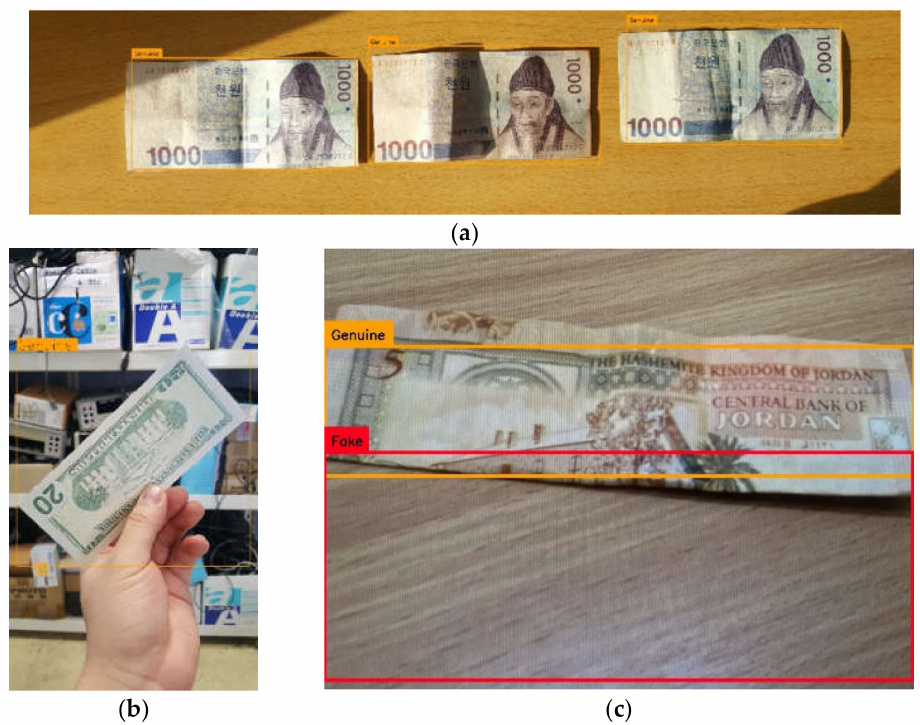
Figure 19. Error cases of ( a ) KRW, ( b ) USD, and ( c ) JOD banknote images using the models trained on the EUR dataset for detection.